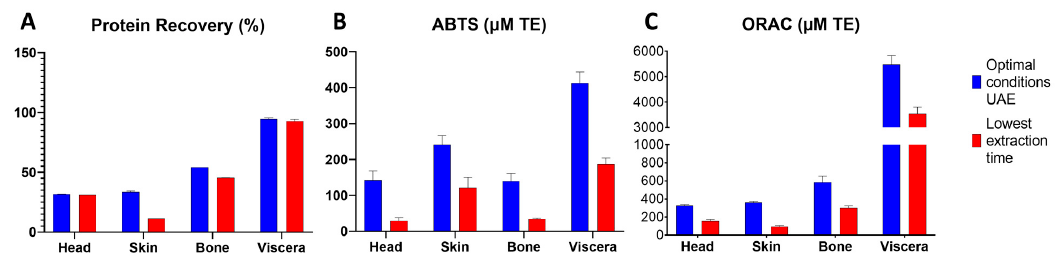
Figure 5. Comparison of the optimal condition with the lowest treatment of UAE (0.5 min): ( A ) protein recovery (%), ( B ) ABTS values (µM TE), and ( C ) ORAC values (µM TE).